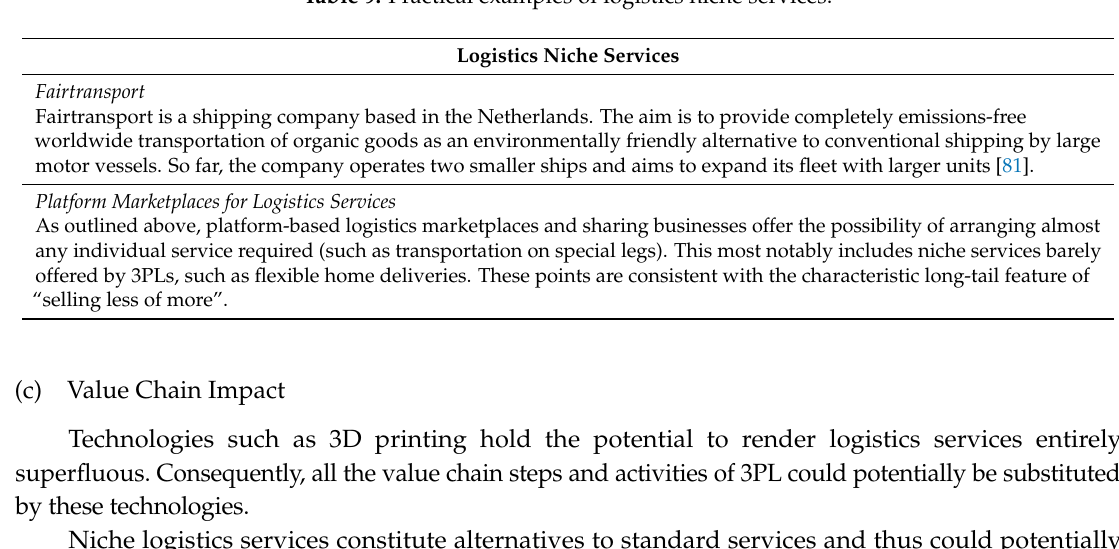
Table 9. Practical examples of logistics niche